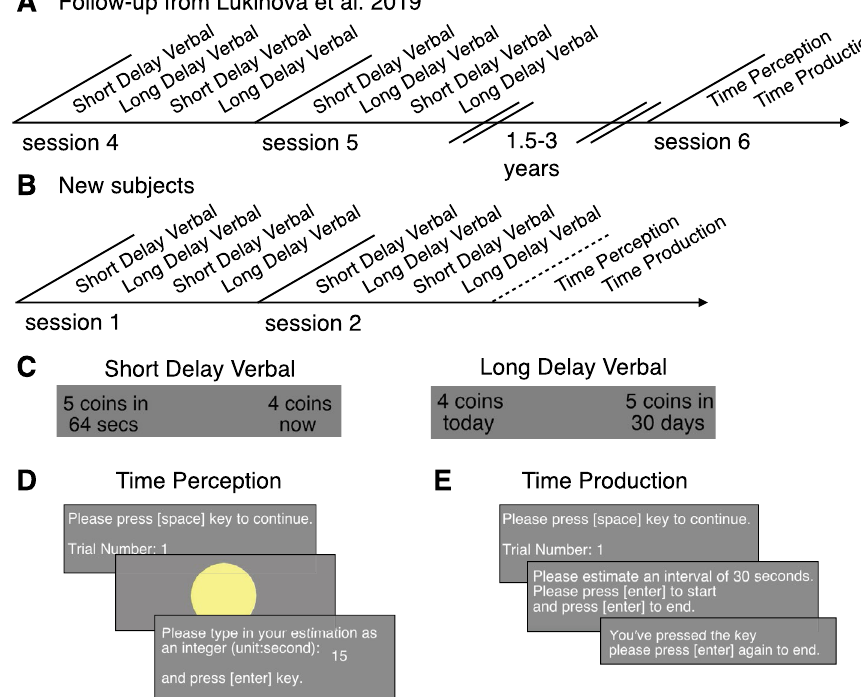
Figure 1. Behavioral tasks. ( A ) Timeline of experimental sessions for the follow-up group ( n = 24 ). During sessions 1–3 (not shown) subjects performed a non-verbal delay-discounting task ( B ) Timeline of experimental sessions for the new group ( n = 26 ). ( C ) Stimuli examples in the intertemporal choice task. ( D , E ) Screenshots of the timing